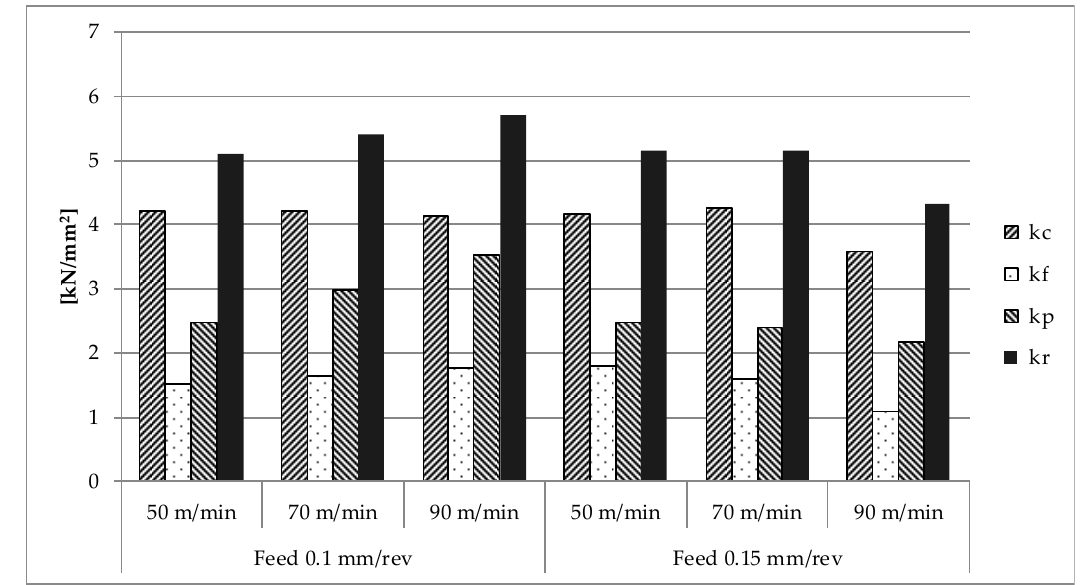
Figure 2. Specific cutting forces for fresh carbide tools at the beginning of the tests.